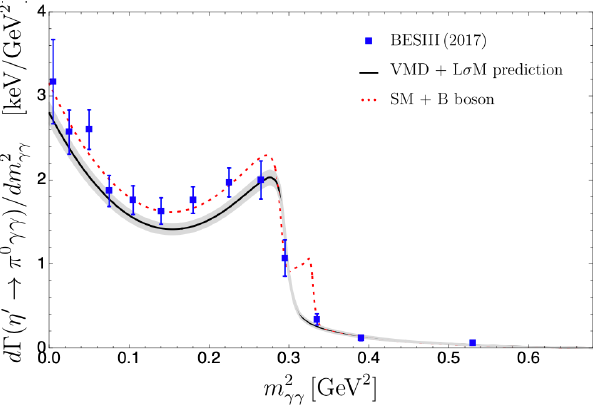
Figure 4. BESIII (blue squares) [11] measurements of the m 2 as well as the SM prediction [3] (solid black line) and SM with B -boson prediction using the fitted parameters from Eq. (9) (dotted red